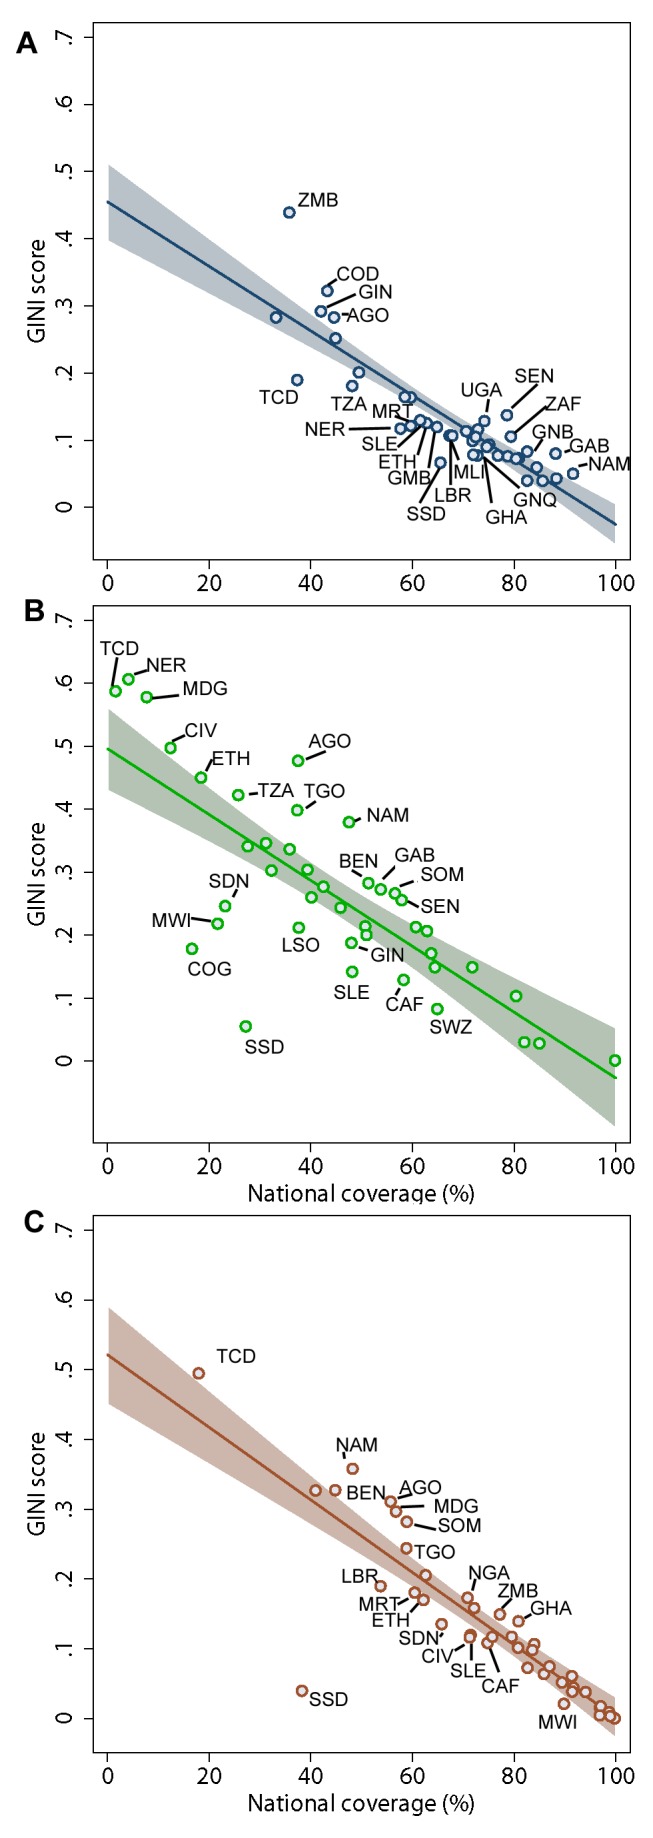
Empirical relationship between inequality (GINI score) as a function of national coverage.Plots are shown for (A) use of improved drinking water, (B) use of improved sanitation facilities, and (C) use of any type of sanitation. All plots show the linear regression prediction (solid line) with 95% confidence interval (shaded area). Labelled countries (by 3-letter ISO codes) are those with GINI scores significantly higher or lower than would be expected, given national coverage.